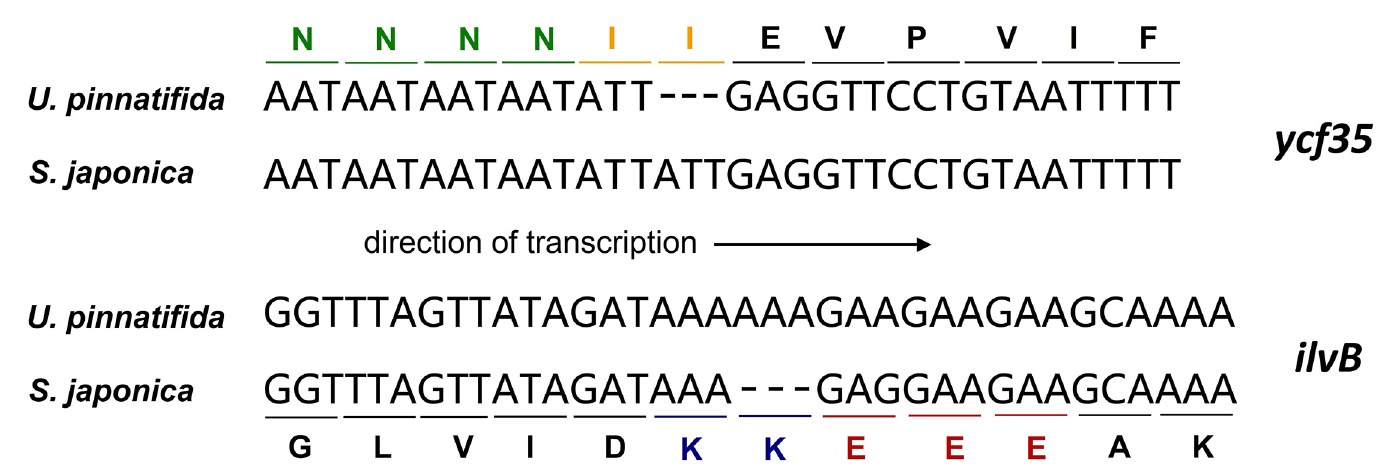
Fig 3. The 3-bp repetitive DNA mutations in U . pinnatifida plastid genes. Colored letters are amino acid sequences corresponding to the nucleotide sequence of each gene for both U . pinnatifida and S . japonica , and “–” represents the deletion of a base.